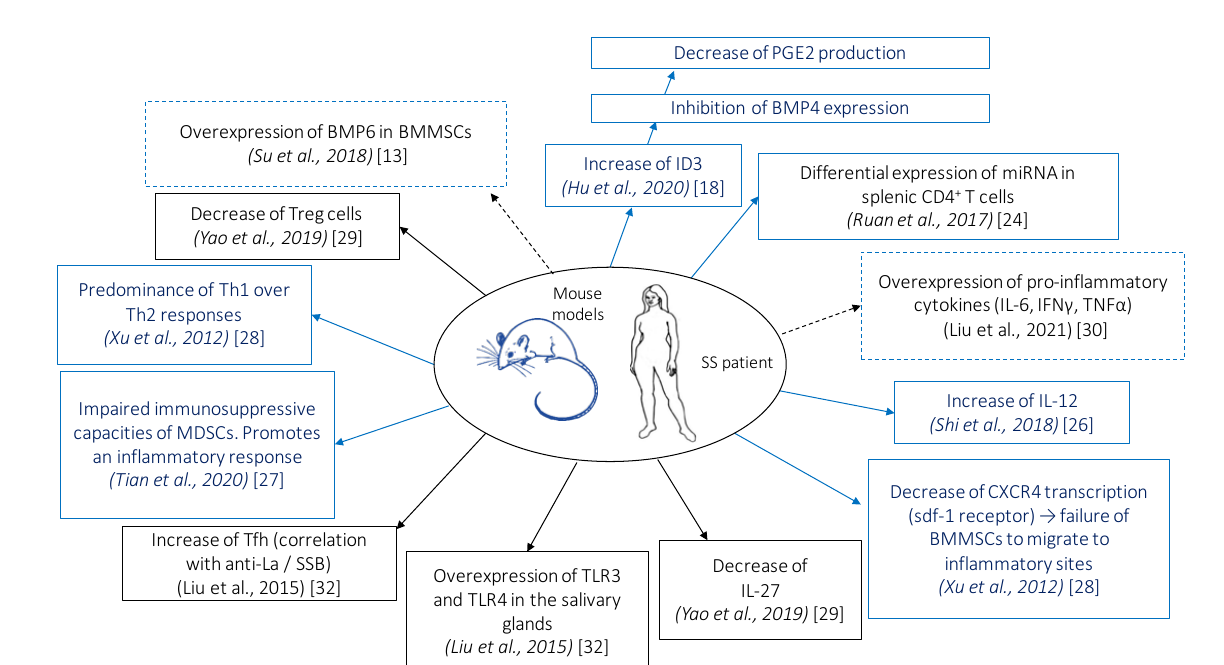
Figure 2. Cellular and molecular modifications induced by mesenchymal stem cell (MSC) administration in patients with Sjögren’s syndrome (SS) and in mouse model of SS. Bone morphogenic protein (BMP), bone marrow MSCs (BMMSCs), DNA binding protein inhibitor (Id), interferon (IFN), interleukin (IL), myeloid suppressor cells (MDSCs), prostaglandin E2 (PGE2), regulatory T cells (Treg), helper T cell (Th), follicular helper T cell (Tfh), toll-like receptor (TLR), tumor necrosis factor (TNF). Solid blue boxes indicate that these observations were made in mice, solid black boxes indicate that these observations were made in humans, and dashed boxes indicate that these observations were made in humans and mice.